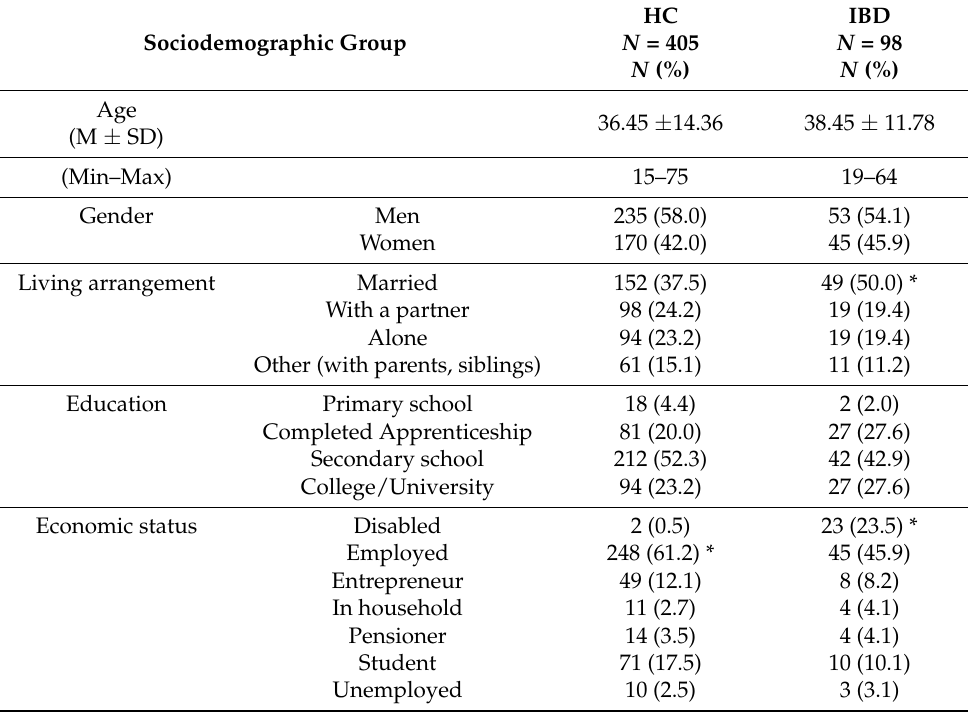
Table 1. Sociodemographic characteristics: the healthy control group (HC) and the group of patients with inflammatory bowel disease